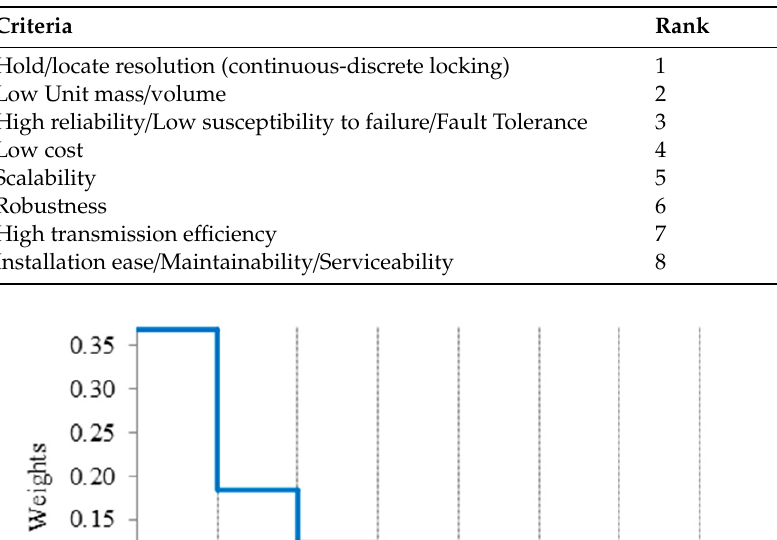
Table 2. Performance criteria and associated importance ranking.